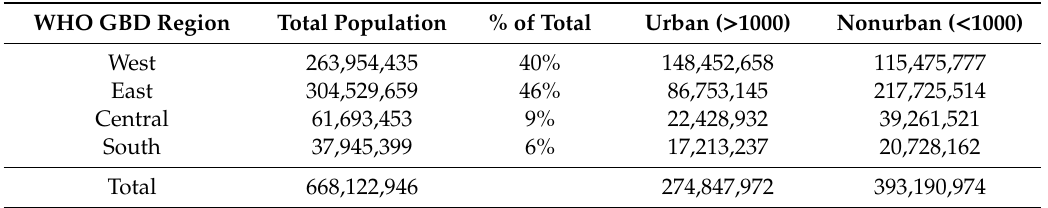
Figure 5. Variable contributions ( top ) and predictive algorithm performances ( bottom ). A. PC: principal component contribution. B. ROC: receiver operating characteristic, KAPPA: Cohen’s Kappa, and TSS: true skill statistic. Table 2. The total population living in environmentally suitable areas in SSA (2020). WHO GBD: WHO Global Burden of Disease